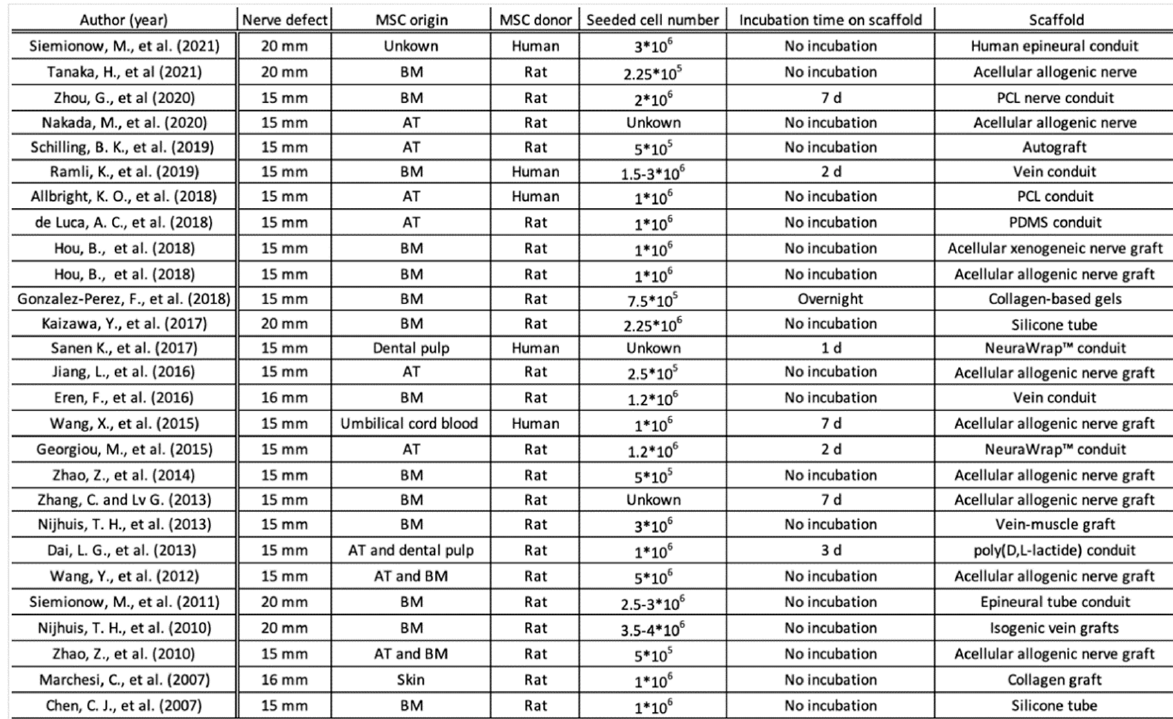
Figure 1. The related studies were searched and included according to the PRISMA guidelines.